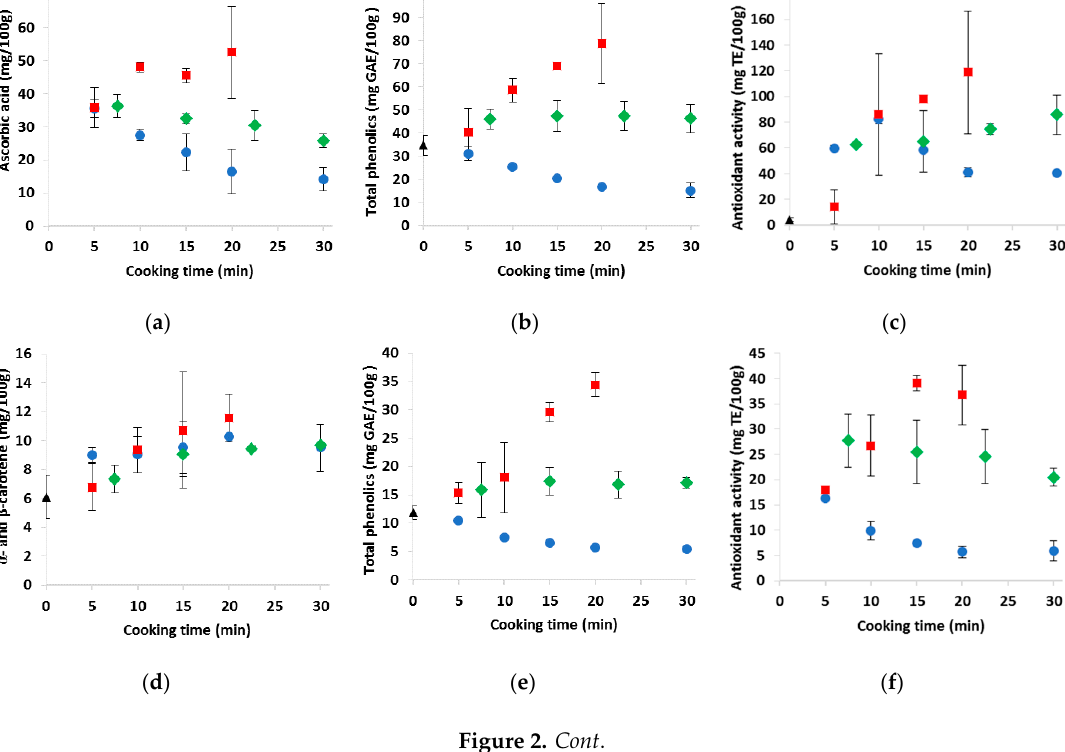
( i ) Figure 2. Nutritional properties of the ( a – c ) cauliflowers, ( d – f ) carrots and ( g – i ) sweet potatoes cooked by the different cooking systems and times. Data are averaged per trial and standard deviation bars are shown. GAE, Gallic acid equivalent; TE, Trolox equivalent; black triangle, raw samples; blue point, boiled samples; green diamond, steamed samples; red square, microwaved samples. 3.3. E-senses Results E-senses (e-nose, e-tongue and e-eye) were applied in order to interpret the effects of boiling, steaming and microwaving on the sensory characteristics of the selected products; the data were combined with the texture parameters and elaborated by PCA into a quality evaluation system that encompasses the evaluation of smell, taste, color and texture, simulating a sensory analysis in a rapid and reliable way. Figure 3 shows the PCA score plots (a, c, e) and the loading plots (b, d, f) of the three selected vegetables.